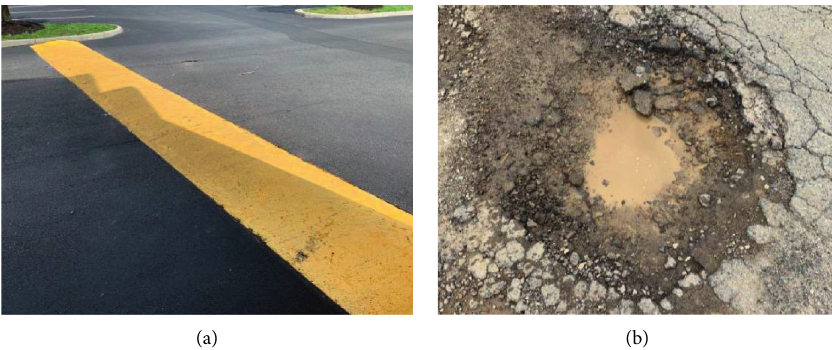
Figure 12: Pavement deterioration samples in Blacksburg, VA. (a) Speedbump sample. (b) Pothole sample.